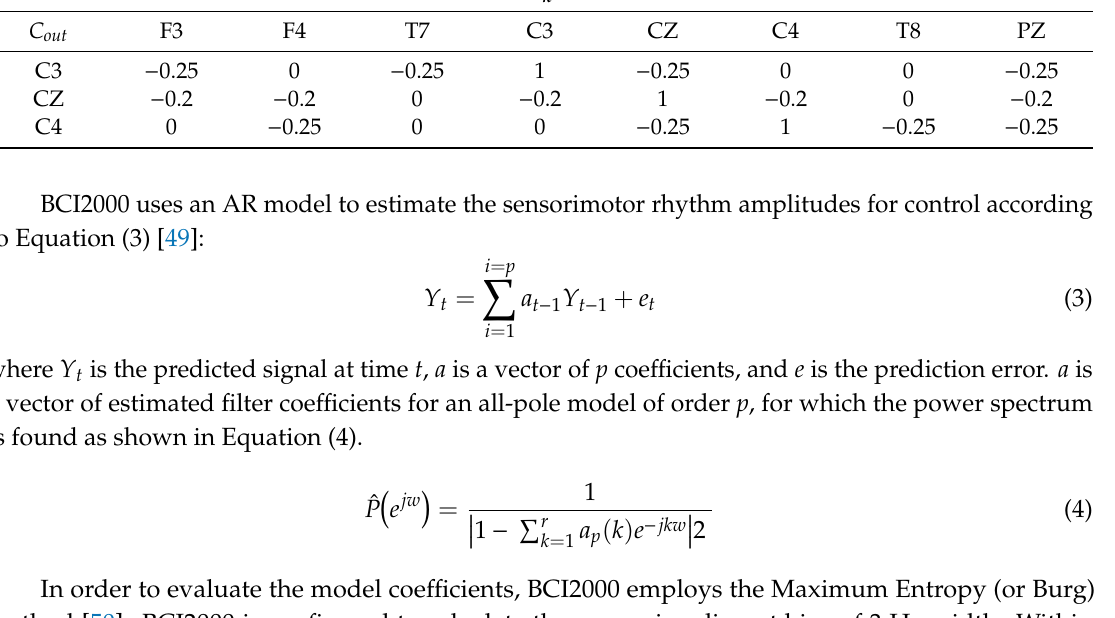
Table 1. Laplacian filter coe ffi cients. C k = electrode k